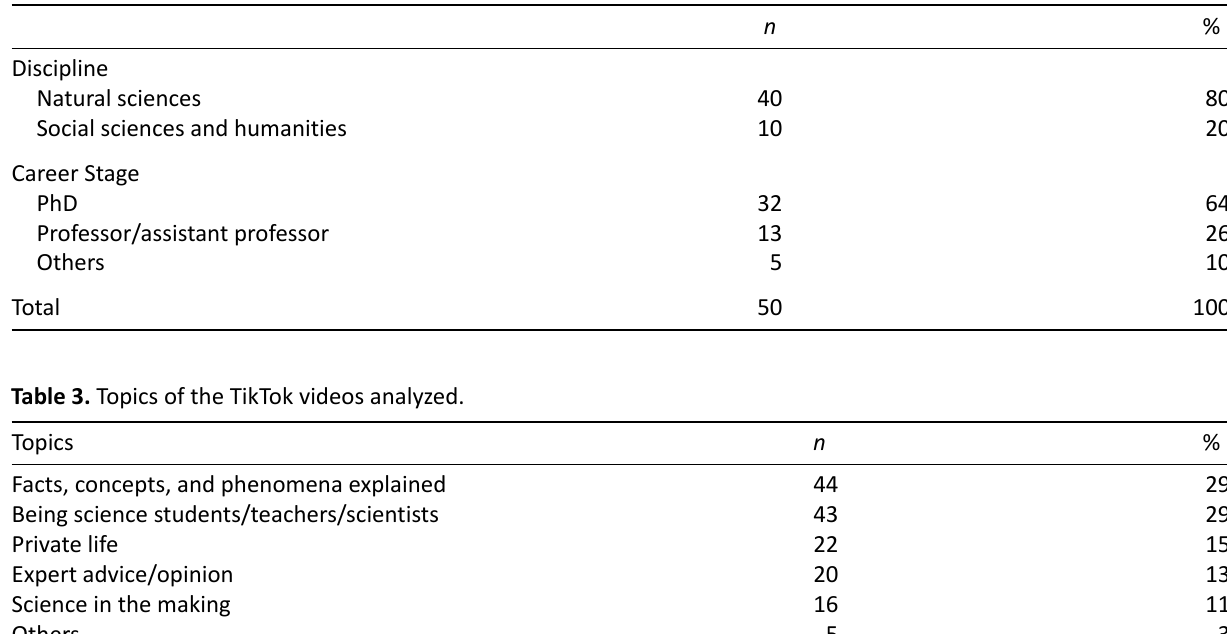
Table 2. Academic discipline and career stage of the female scholars on TikTok studied.